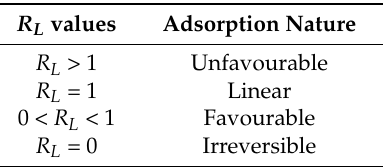
Table 1. Nature of adsorption from Langmuir isotherm fitted equilibrium data. R L